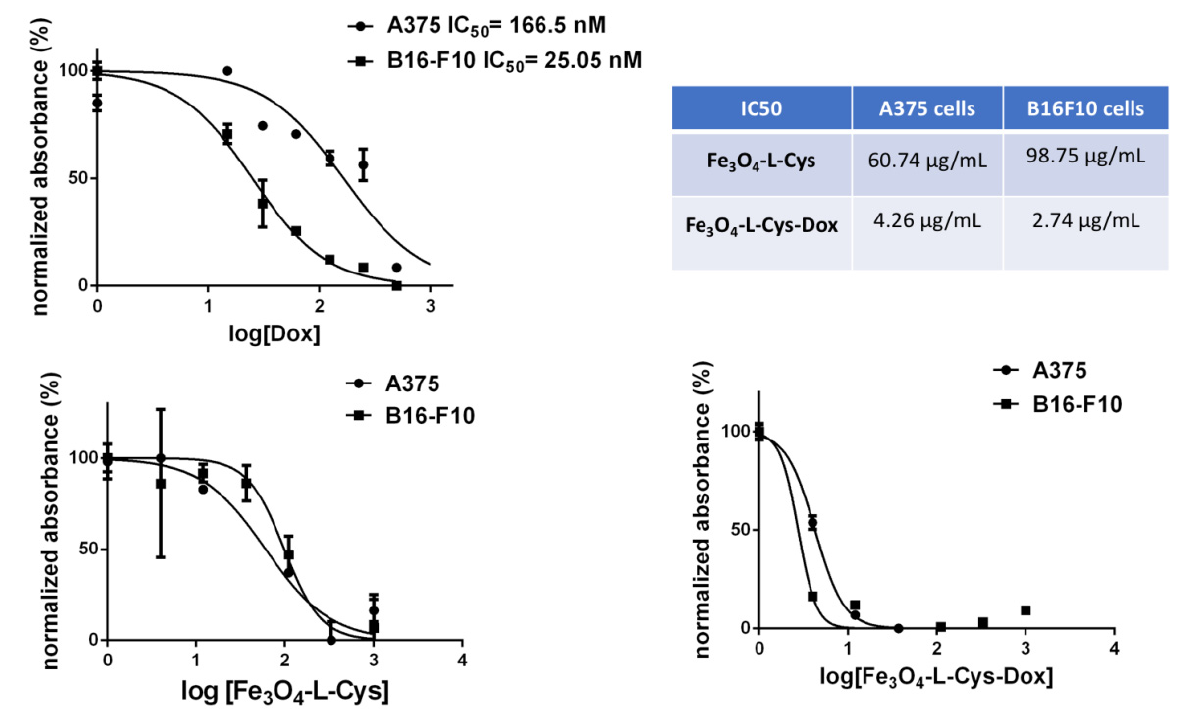
Figure 11. Determination of the half inhibitory concentration (IC50) of Fe 3 O 4 -L-Cys and Fe 3 O 4 -L-Cys-Dox NPs on human A375 and murine B16F10 melanoma cells at 72 h post-treatment, as compared to free Dox.